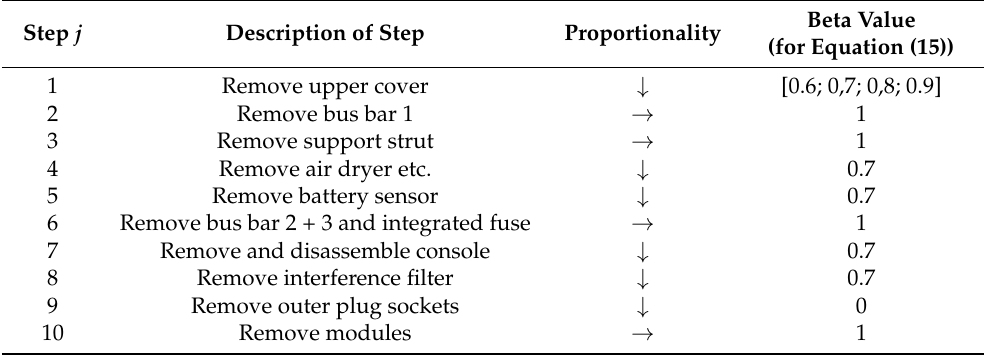
Table 8. Evaluation of proportional influence on disassembling time with increasing EVBS battery module